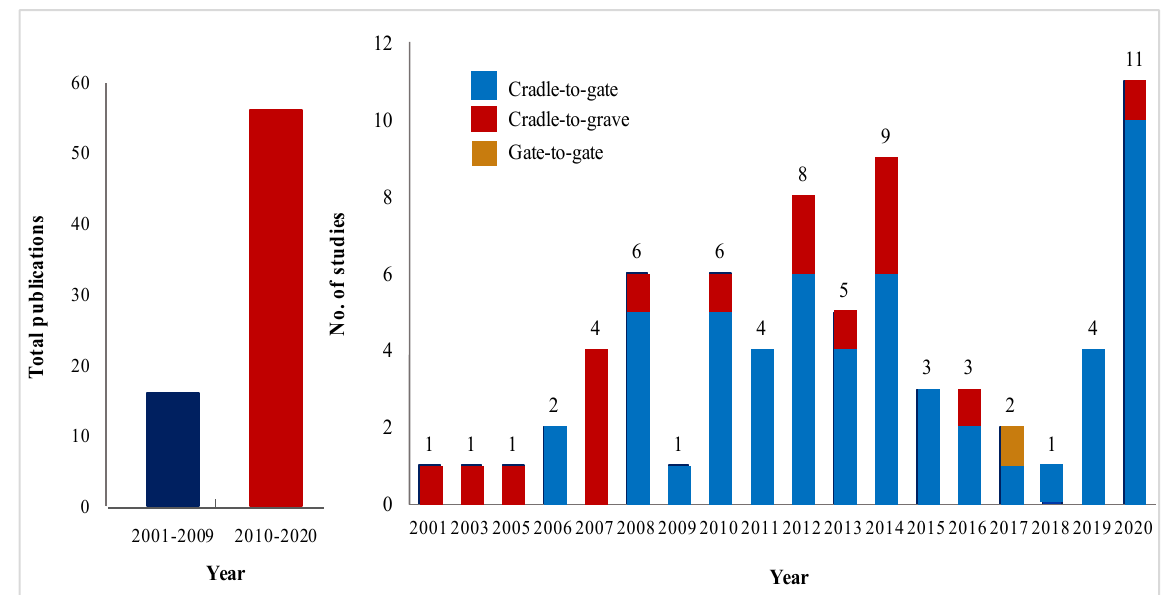
Figure 3. Distribution of papers based on the year and system boundary.